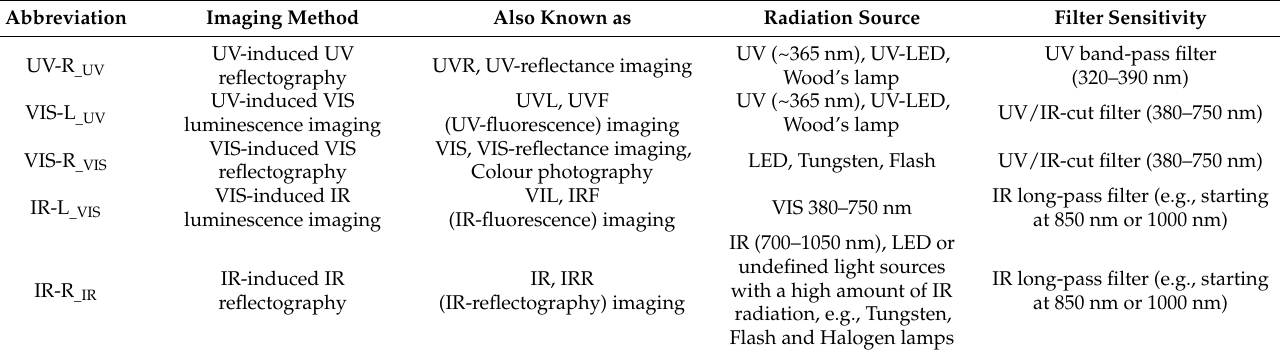
Table 1. Overview of spectral images commonly used in